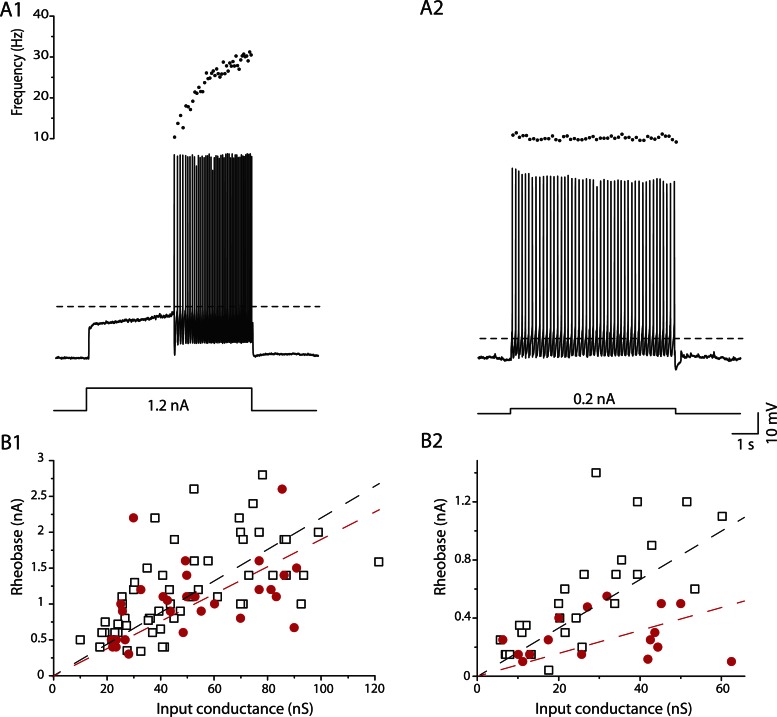
mSOD1 immediate firing motoneurons are selectively hyperexcitable.(A1-2) mSOD1 motoneurons displaying the delayed firing pattern (A1) and the immediate firing pattern (A2). The current intensity was the minimal intensity necessary to elicit firing (rheobase). Bottom: injected-current (square pulses), middle: voltage-response and top: instantaneous firing frequency. The horizontal dashed line shows the voltage threshold for spiking (−37 mV for the delayed firing motoneuron and −48 mV for the immediate firing motoneuron). (B1-2) Plot of rheobase as a function of input conductance for delayed (B1) and immediate (B2) firing motoneurons. In each plot, open squares are for WT motoneurons whereas red dots are for mSOD1 motoneurons. Linear regressions are indicated by dashed lines.